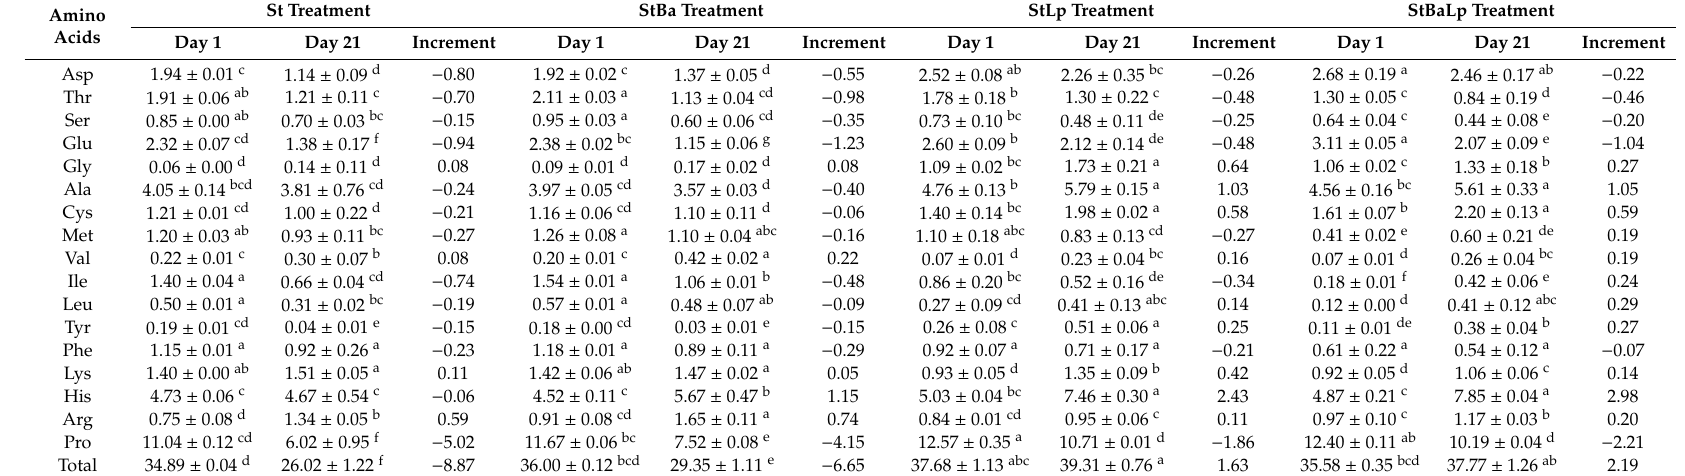
Table 3. Changes of free amino acids (mg / kg) in fermented milk from di ff erent starter cultures during 21-day storage at 4 ◦